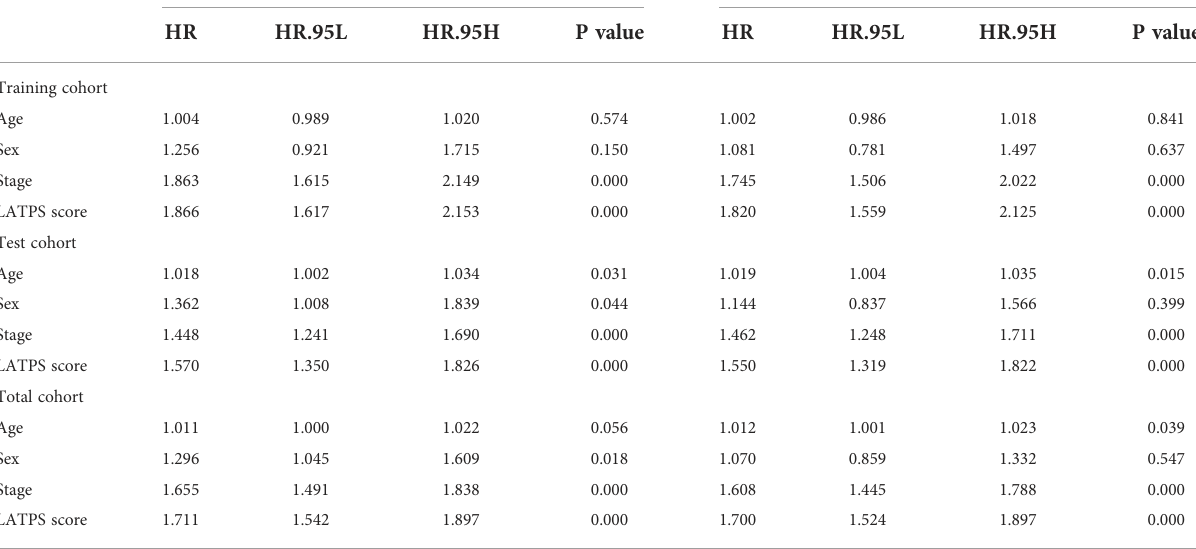
TABLE 3 Univariate and multivariate Cox regression analysis in training, test, and total cohorts. Variables Univariate analysis Multivariate